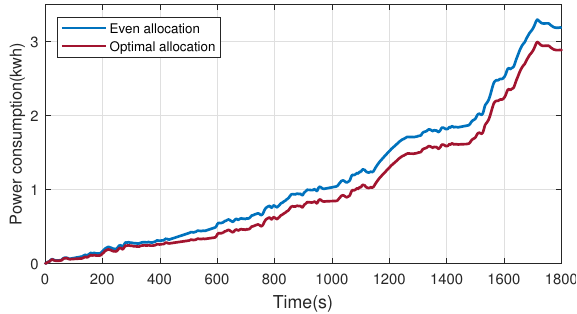
Figure 11. Energy consumption in WLTC